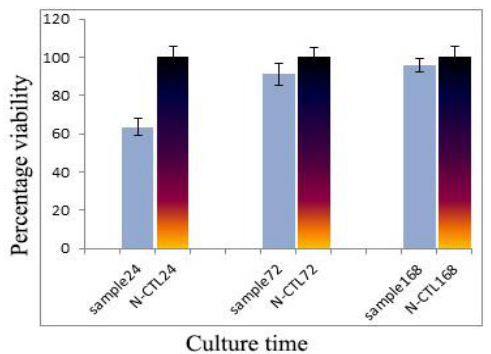
Fig. 4. Shows the MTT assay of the bioceramic after different times of cells